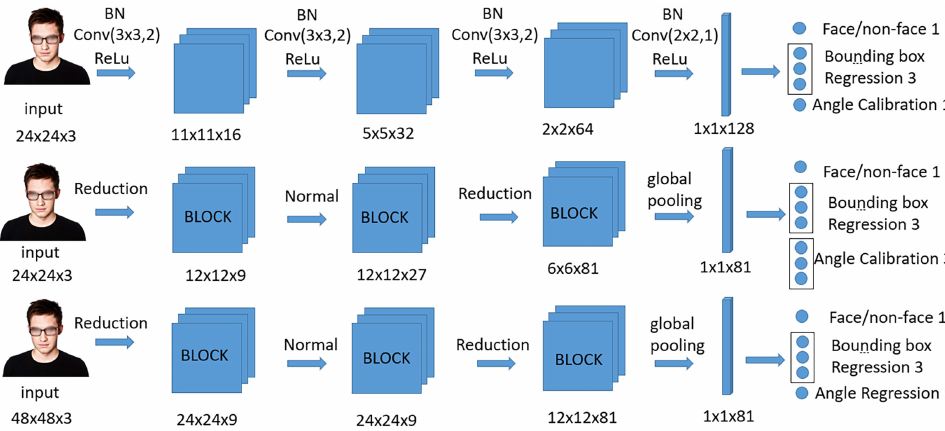
Figure 8. The structure of the SACN, Conv, BN, ReLU, global pooling mean convolution layer, Batch Normalization, ReLU activation layer, and global pooling layer, respectively. (k,k,s) indicates that the kernel size is k × k and the stride is s. Reduction and Normal operations were learned by SACN, as shown in Figures 5 and